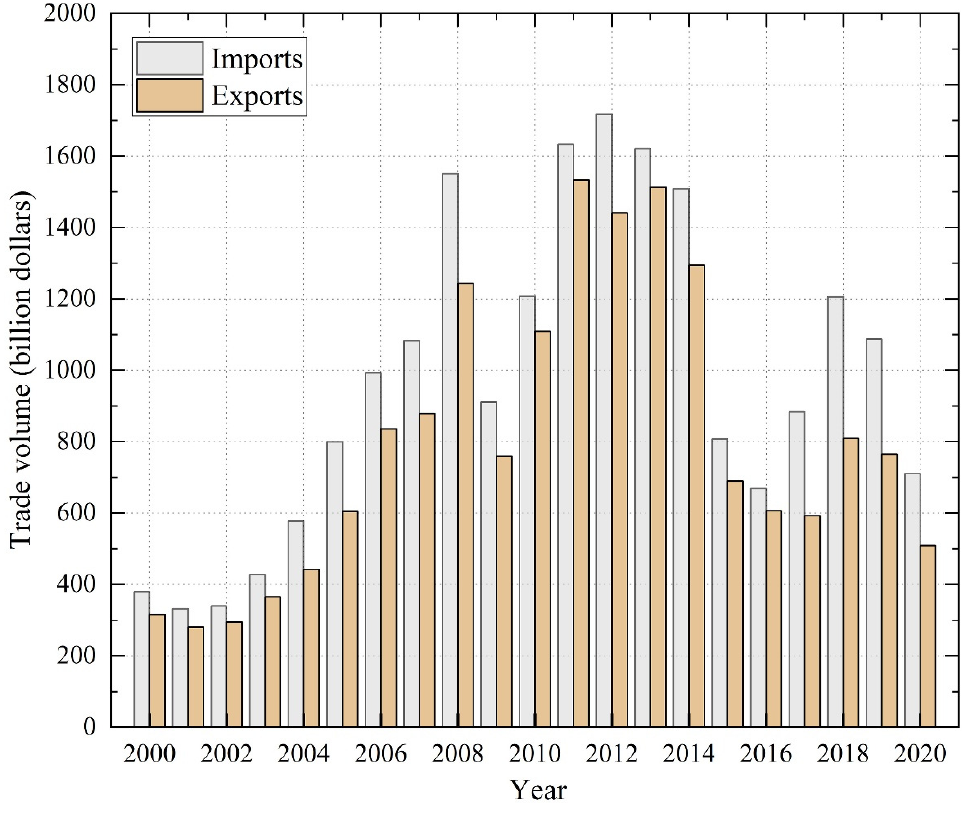
Figure 1. Changes in global crude oil import and export trade volume.